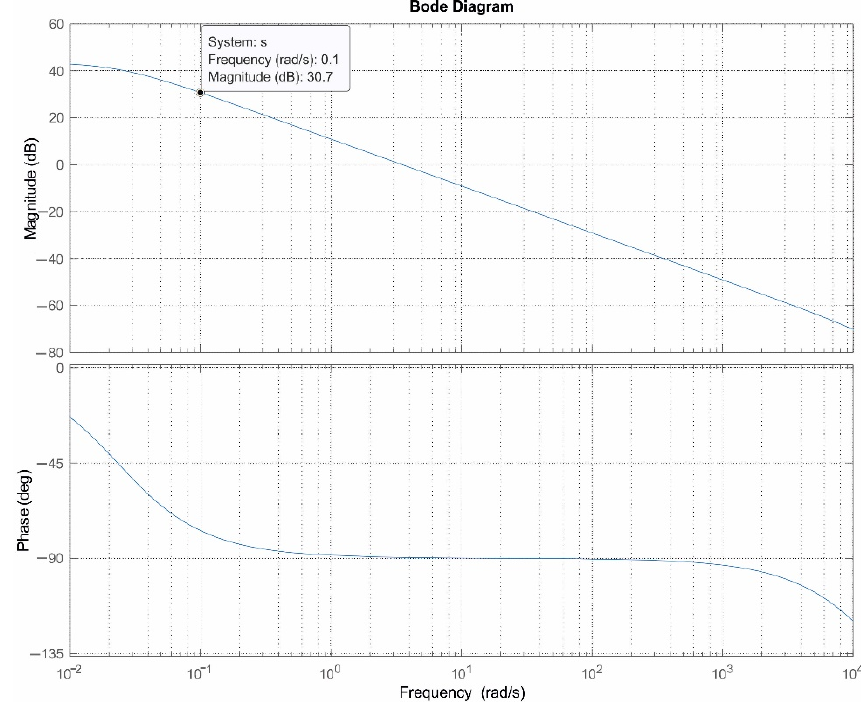
Figure 19. Bode characteristic of the system S ( s ).